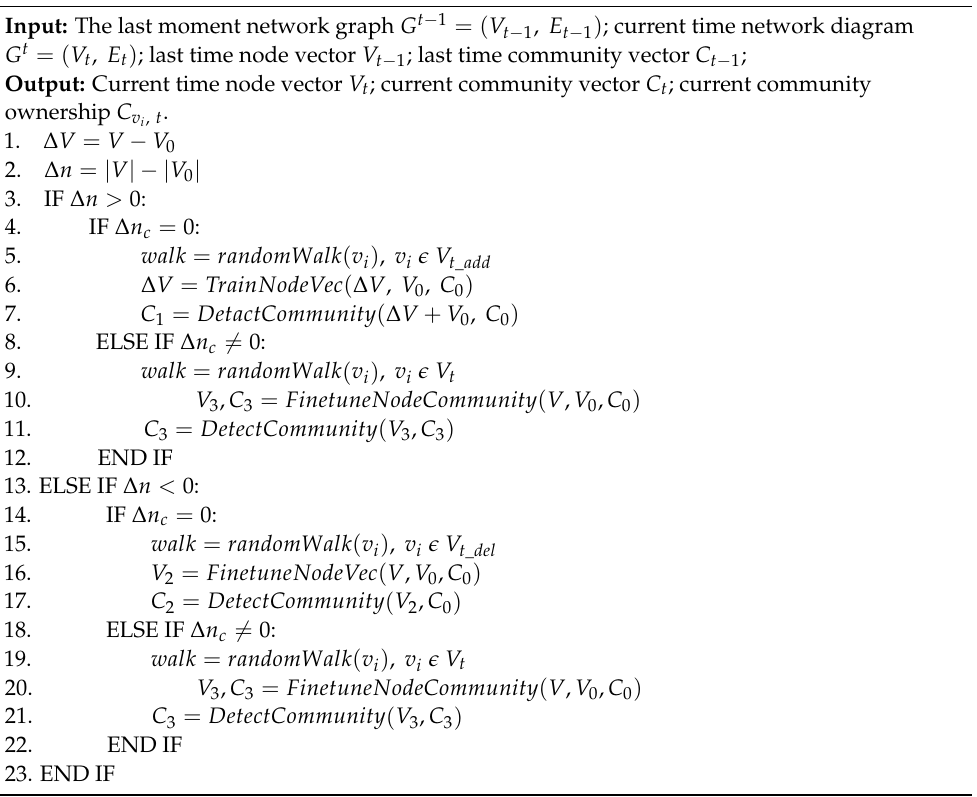
Algorithm 5 Fine-grained division of dynamic